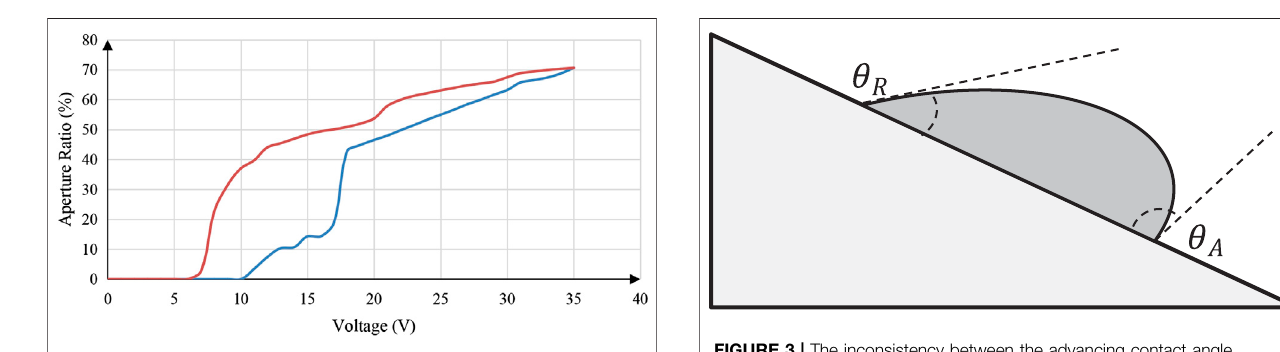
FIGURE 3 | The inconsistency between the advancing contact angle and the receding contact